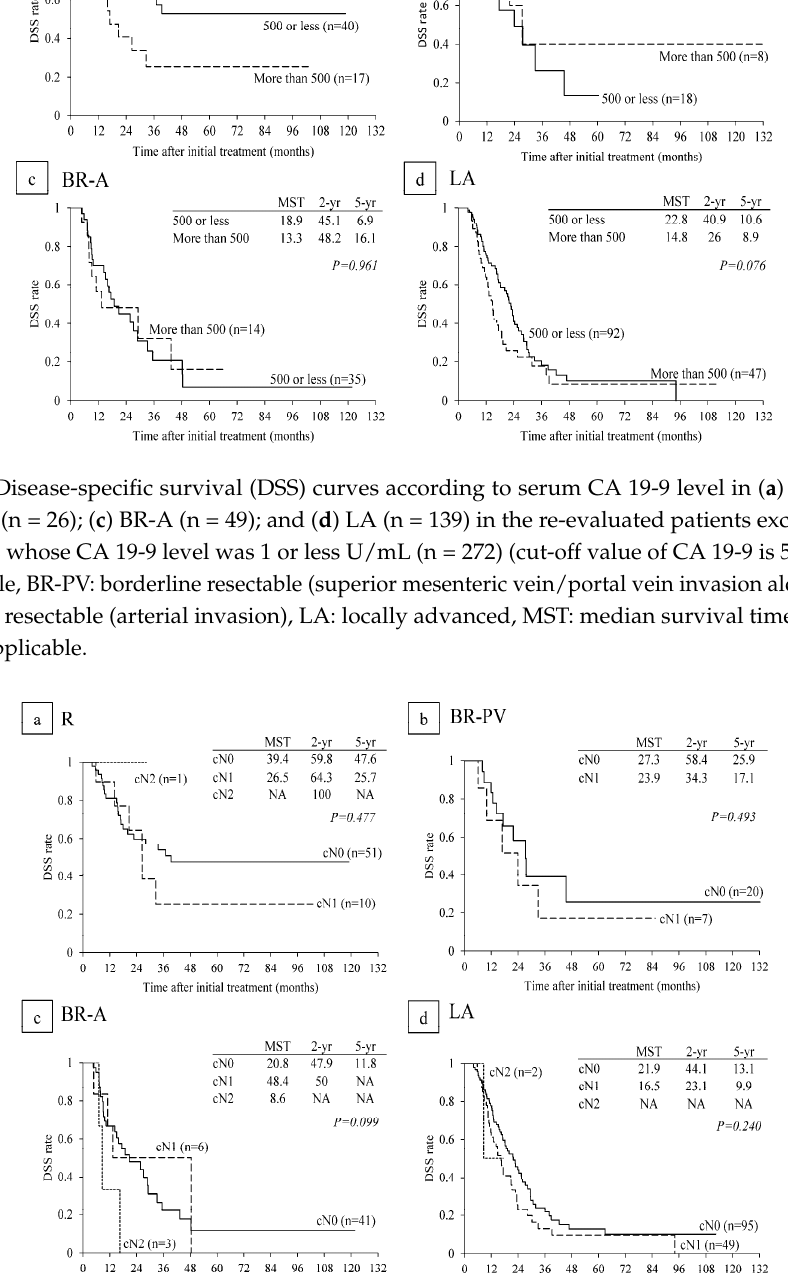
Figure 6. Disease-specific survival (DSS) curves according to lymph node metastaseon CT before CRT in ( a ) R (n = 62); ( b ) BR-PV (n = 27); ( c ) BR-A (n = 50); and ( d ) LA (n = 146). R: resectable, BR-PV: borderline resectable (superior mesenteric vein/portal vein invasion alone), BR-A: borderline resectable (arterial invasion), LA: locally advanced, MST: median survival time (months), NA: not applicable.